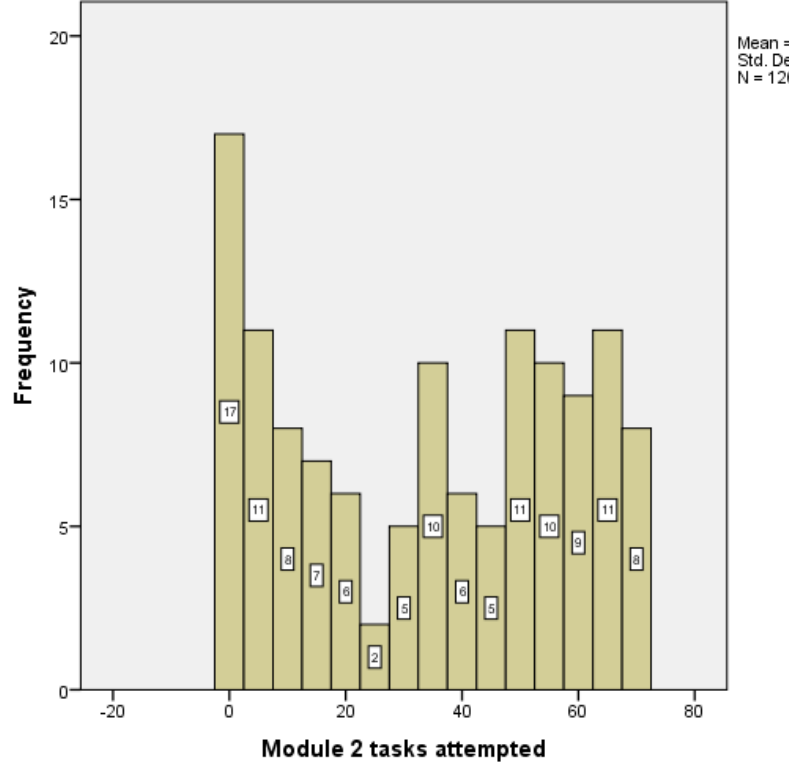
Figure 3: Distribution of knowledge check quiz completions in Module